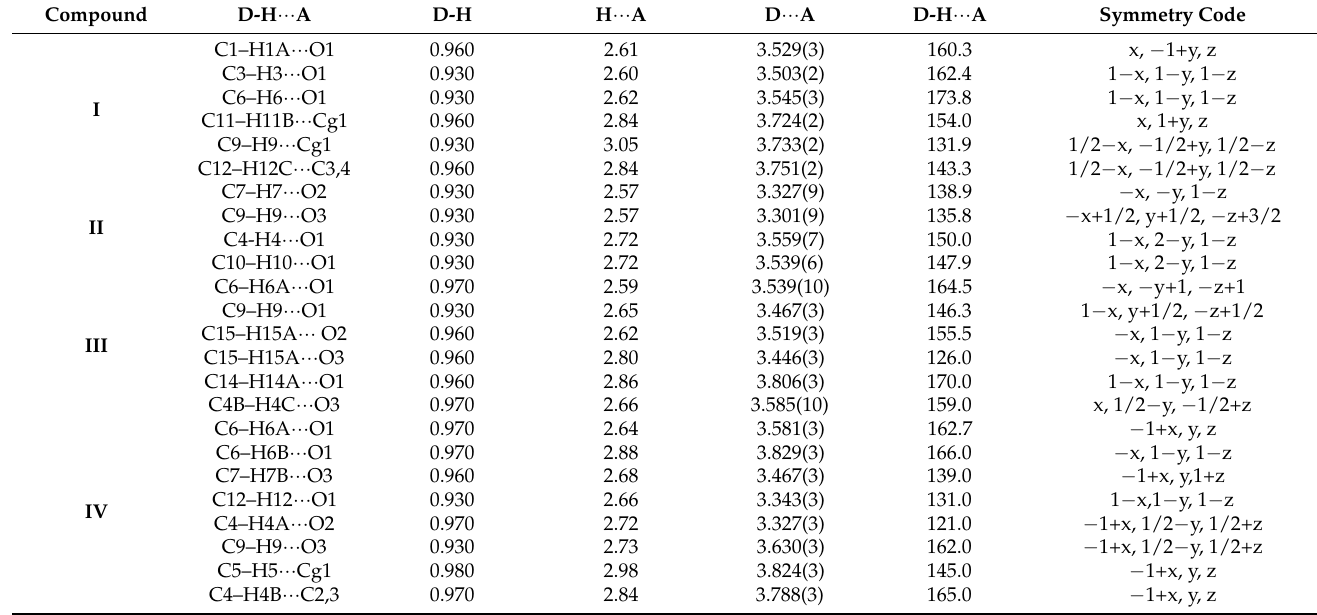
Table 2. Geometry of the hydrogen bonding interactions (Å, ◦ ) for compounds